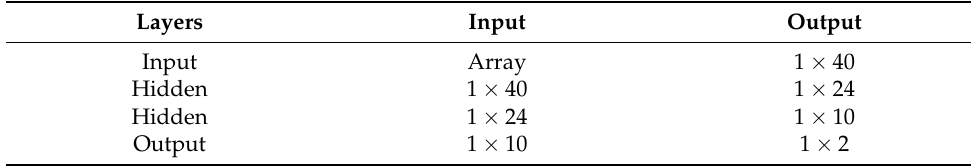
Table 2. Architecture of BP